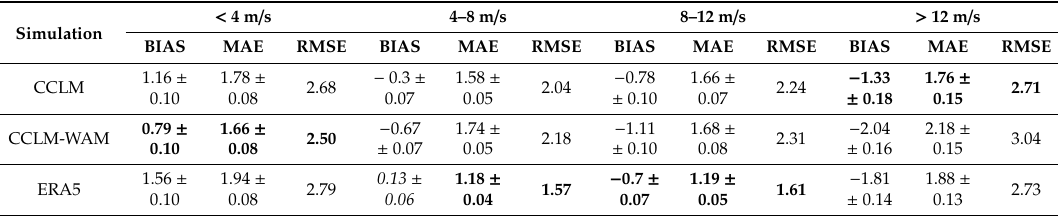
Figure 2. Taylor diagrams comparing the observations with three wind products for each station in 2010. The black contour lines represent the normalized centered root mean square errors, the blue contour lines represent the normalized standard deviations, and the azimuthal position of the point represents the correlation coefficient between the modeled and observed wind data. Table 3. Bias (m / s), mean absolute error (MAE, m / s) and root mean square error (RMSE, m / s) for each range of wind speed between simulated results and observations. 95% confidence interval of bias and MAE are listed. Italic value means that it does not pass the significance test at a level of 0.05. Bold represents the best skill in each column.